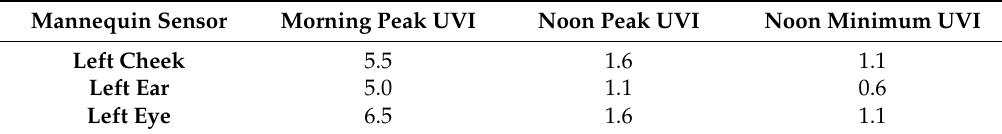
Table 3. Maximum and minimum mannequin head sensor UVI values plotted in Figure 5.